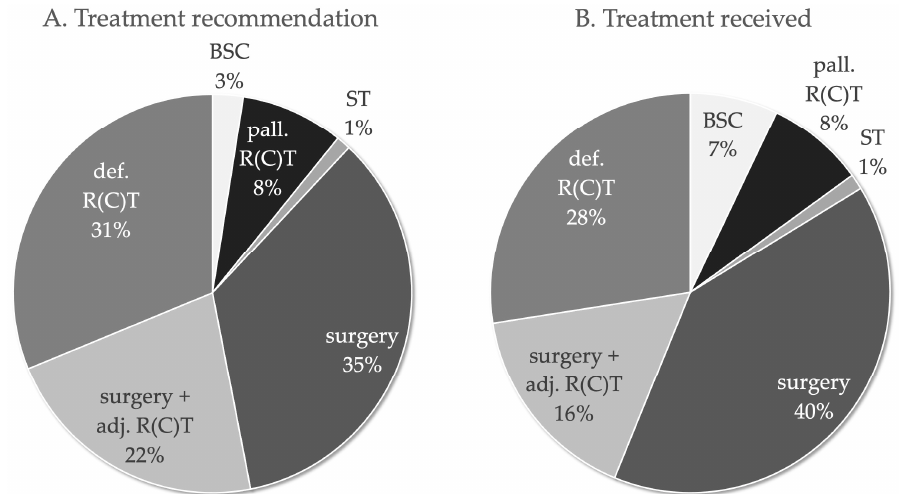
Figure 1. Treatment recommendations of the multidisciplinary tumour board of 1125 patients with HNSCC ≥ 70 years. ( A ). Treatment recommended and ( B ). treatment received.